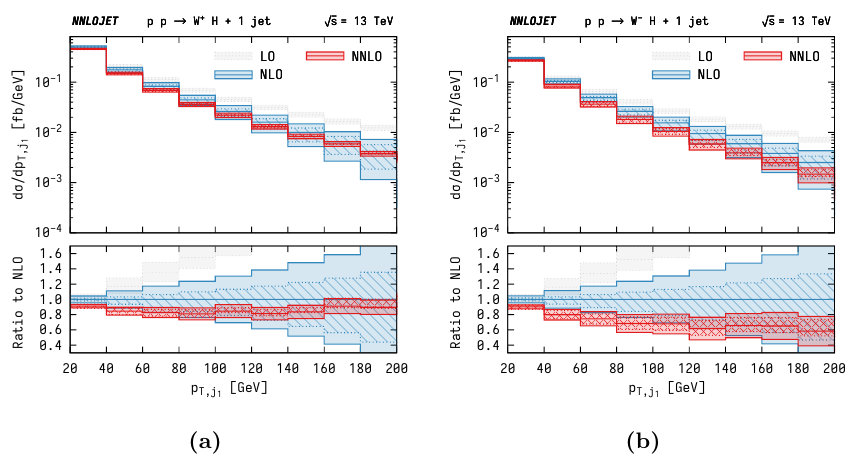
Figure 6. The transverse momentum distribution of the jet produced in exclusive WH + jet production for (a) W + (b) W − .